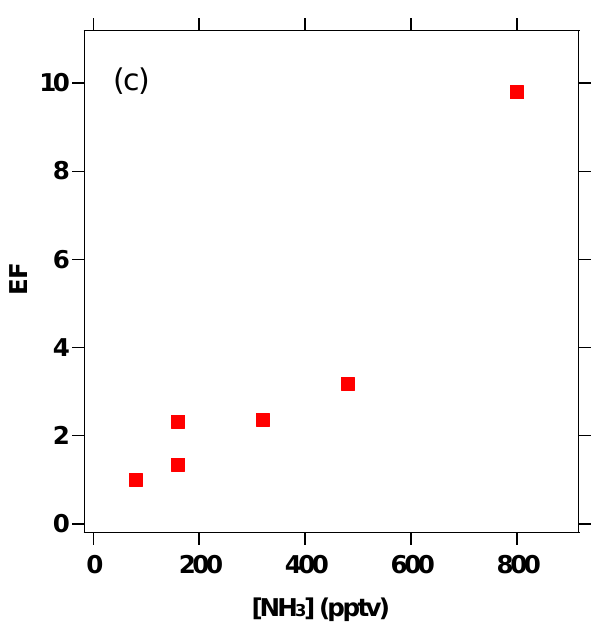
Fig. 5c. The measured EF as a function of [NH 3 ]. [H 2 SO 4 ]=8 . 2 × 10 6 cm − 3 . RH=8%. Residence Figure 5c. The measured EF as a function of [NH 3 ]. [H 2 SO 4 ] = 8.2×10 6 cm -3 . RH = 8%. 665 Residence time = 170 s. 666 667